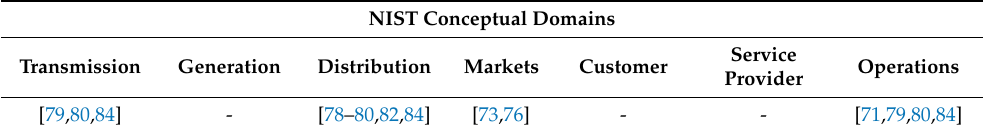
Table 6. Research on MAS-based trust in Smart Grid categorized by NIST conceptual domains.